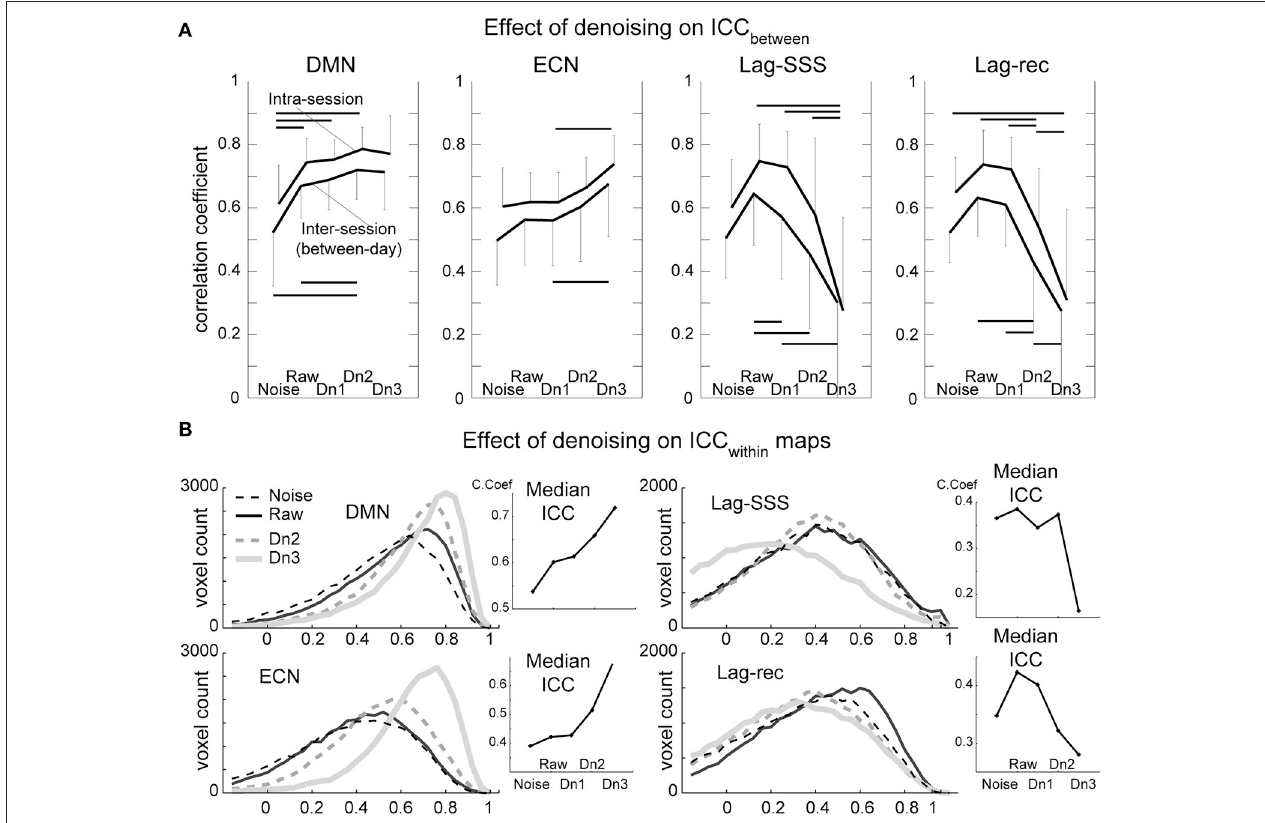
FIGURE 4 | Results from the reproducibility experiment. (A) Test-retest reliability and denoising. Image similarity quantified by ICC between is plotted against denoising strength. FC maps became more stable by increasing denoising strength, whereas lag maps presented the highest reproducibility in the raw dataset. The overall effect of denoising on reproducibility was significant for all four BOLD metrics (Friedman test, P < 0.001) except for the ECN ( P = 0.07). Error bars signify 95% confidence intervals ( n = 10). Horizontal bars denote a significant difference ( P < 0.01) by the paired t -test. (B) . Reproducibility of measurements within each voxel (ICC within ) is shown in histogram form. This analysis revealed superior performance of aggressive denoising (Dn3) over the moderate level (Dn2) on FC maps. For lag maps, the effect of denoising was the